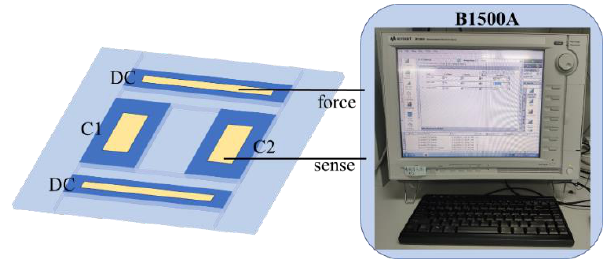
Figure 7. Diagram of the capacitance test.